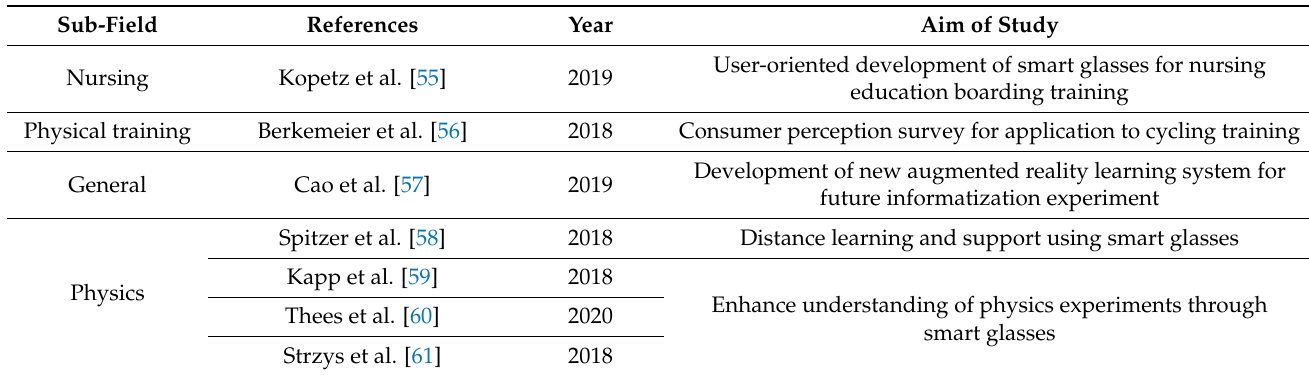
Table 5. Summary of smart glass applications in the field of